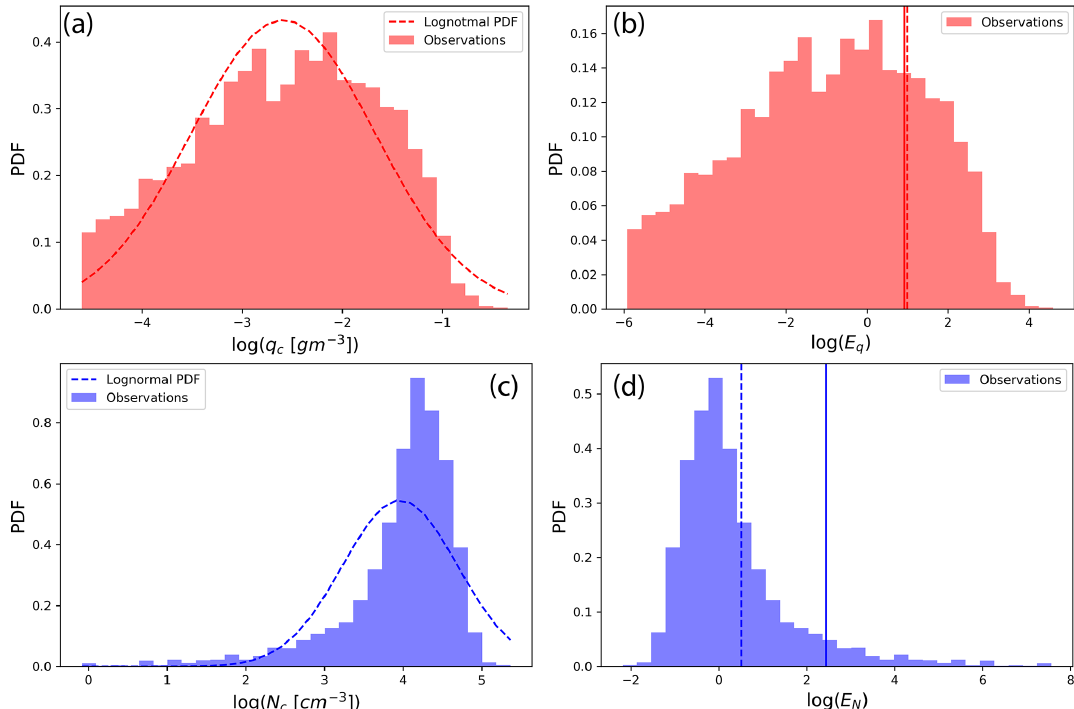
Figure 7. (a) Histogram of ln (q c ) based on observations from hleg 10 (bars) and the lognormal PDF (dashed line) based on the µ q σ q of hleg 10. (b) The histogram of ln (E q ) diagnosed from the observed q c based on Eq. (9). The two vertical lines correspond to the c leg-averaged ln (E q ) derived based on the observed q c (solid) and the lognormal PDF (dashed line), respectively. (c) Histogram of ln (N c ) based on observations from hleg 10 (bars) and the lognormal PDF (dashed line) based on the µ N ln (E N ) diagnosed from the observed q c based on Eq. (10). The two vertical lines correspond to the leg-averaged ln (E N ) derived based on the observed N c (solid) and the lognormal PDF (dashed line),